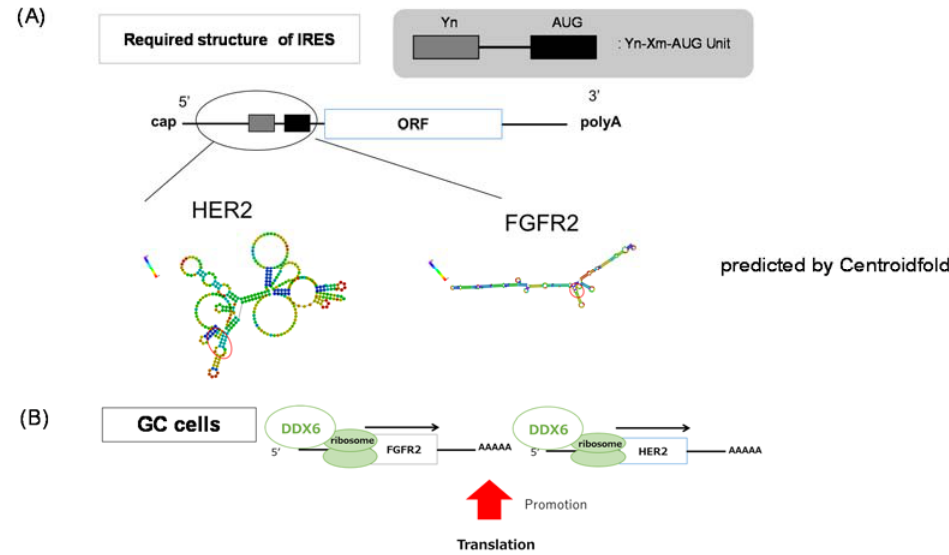
Figure 6. Predicted IRES structure of the HER2 and FGFR2 mRNAs. ( A ) IRES structure in the 5 ′ UTR of HER2 and FGFR2 mRNAs as predicted by Centroidfold (http://rtools.cbrc.jp/centroidfold/); ( B ) The scheme of DDX6 regulation of HER2 and FGFR2 in the translational step.